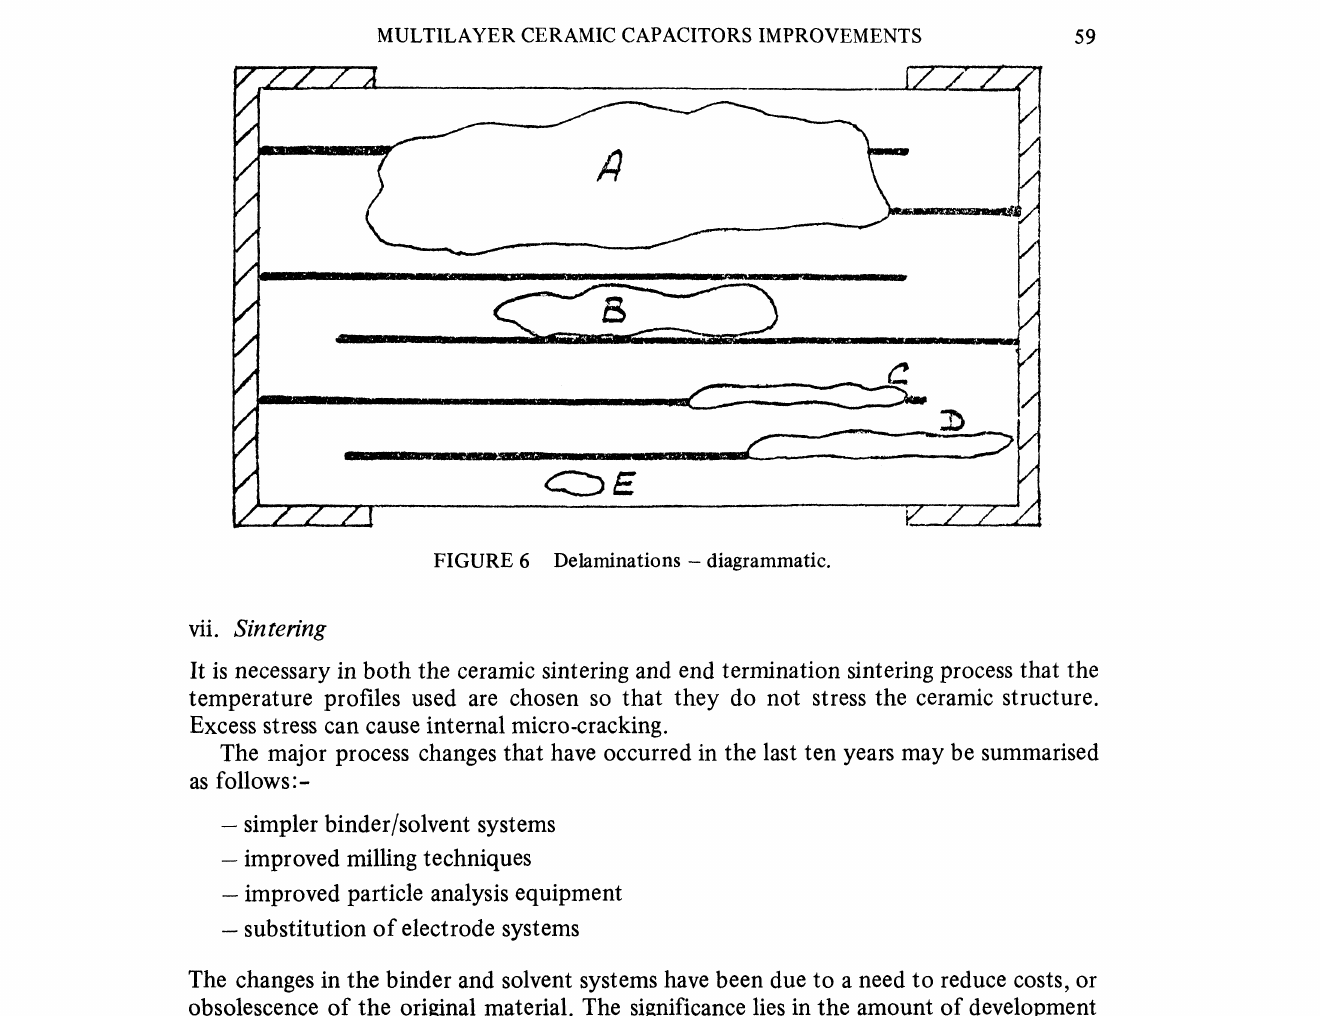
FIGURE 6 Delaminations